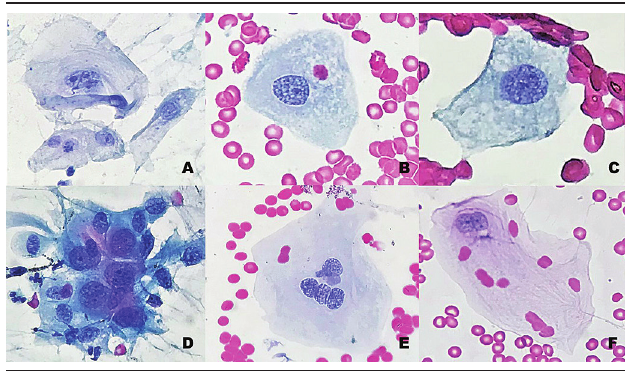
FigurE 3 − Benign reactive cellular changes associated with radiation A) squamous epithelial cell with cellular gigantism and anisonucleosis; B) cell evidencing nuclear degeneration; C) cell with cytoplasmic vacuolization and nuclear degeneration; D) reactivity in metaplastic cells, with anisokaryosis and nucleoli; E) multinucleated giant cell; F) cellular gigantism and binucleation (magnification